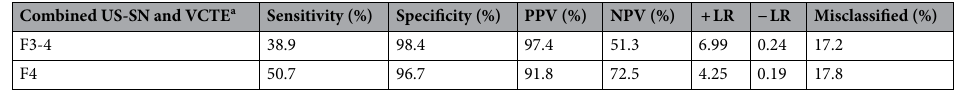
Table 5. Diagnostic performance of combined ultrasound surface nodularity and VCTE for advanced fibrosis and cirrhosis. LR, likelihood ratio; NPV, negative predictive value; PPV, positive predictive value; SN, surface nodularity; VCTE, vibration controlled transient elastography. a Liver stiffness measurement ≥ 9.6 kPa for F3-4 and ≥ 10.2 kPa for